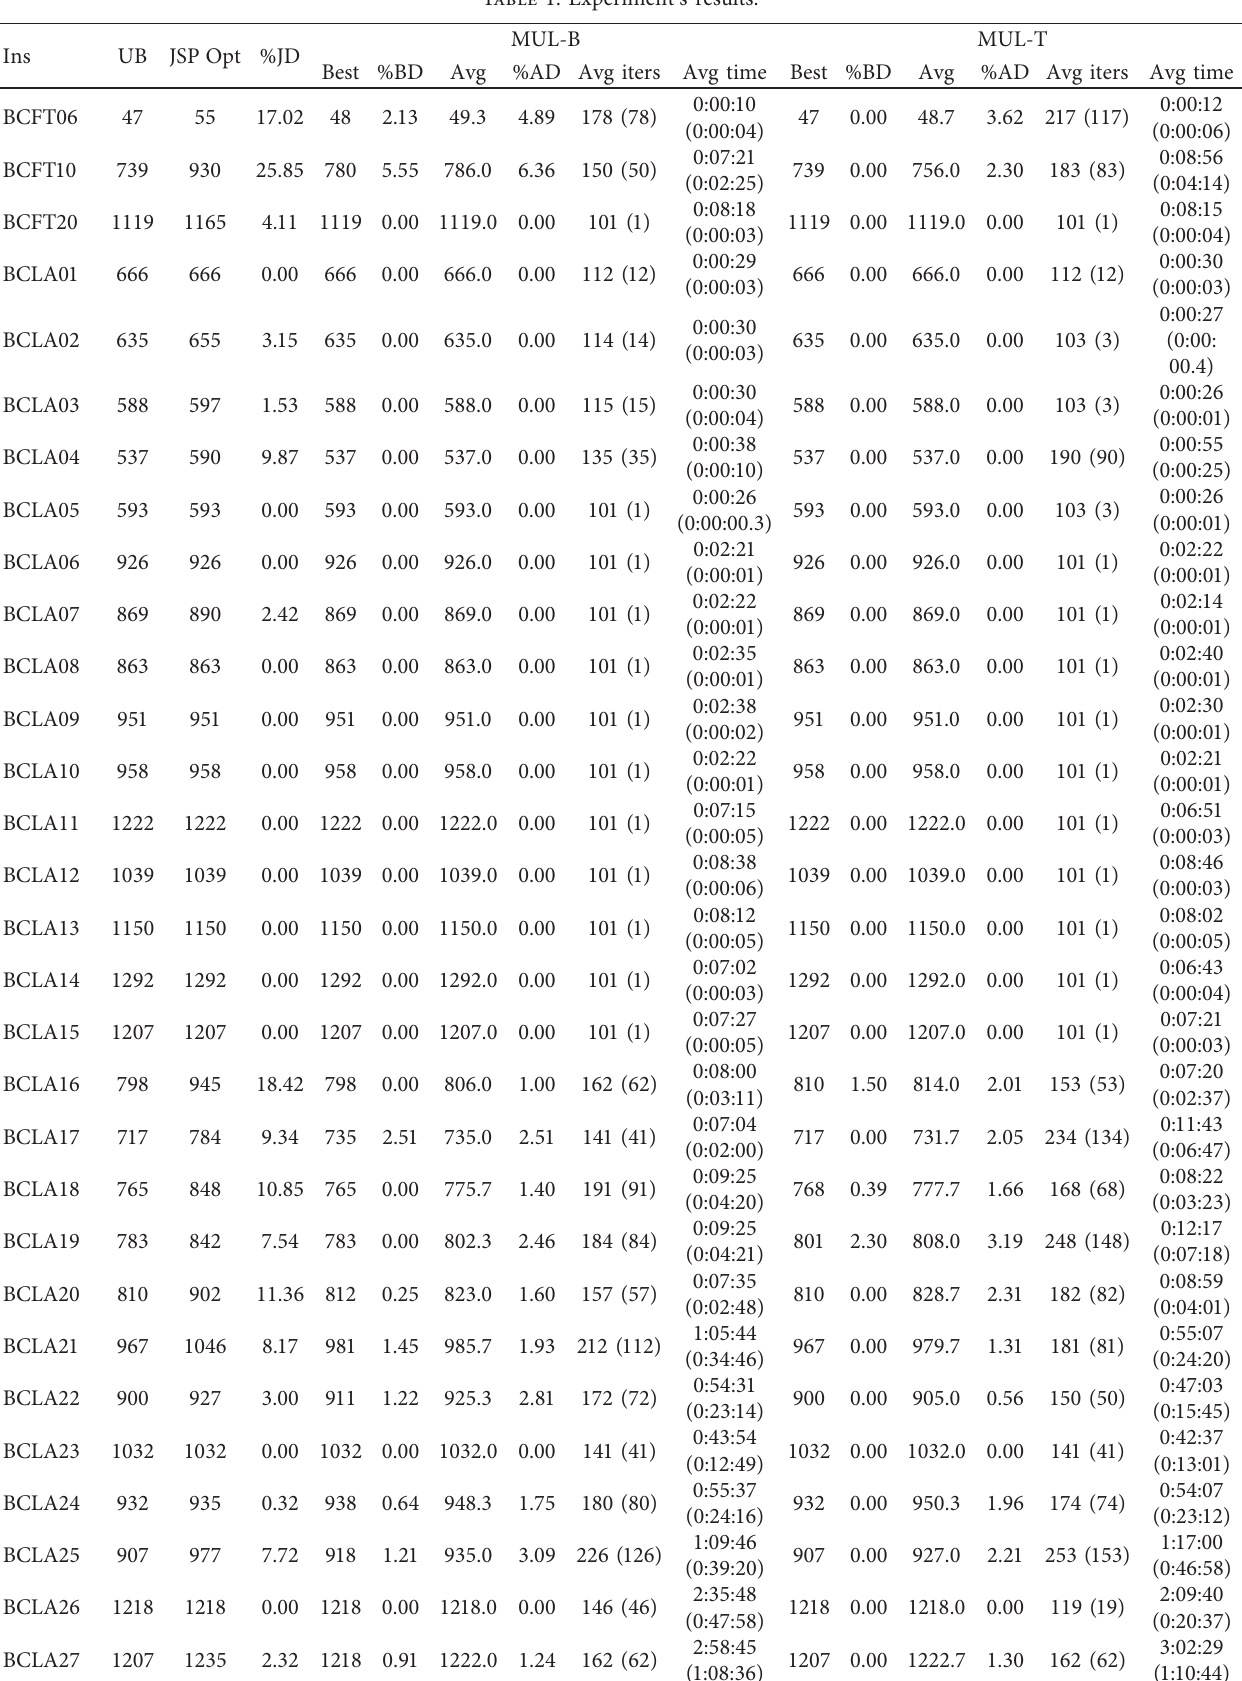
Table 1: Experiment’s